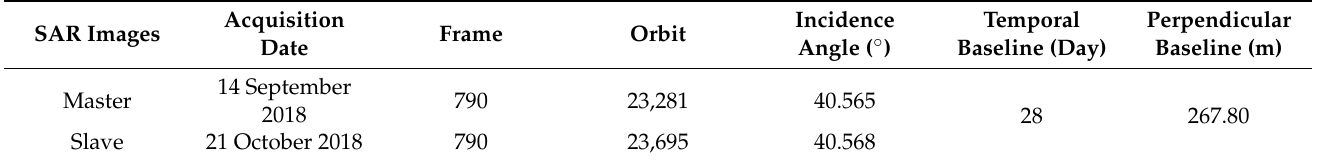
Table 2. Basic parameters of PALSAR2 images in the Datong mining area.